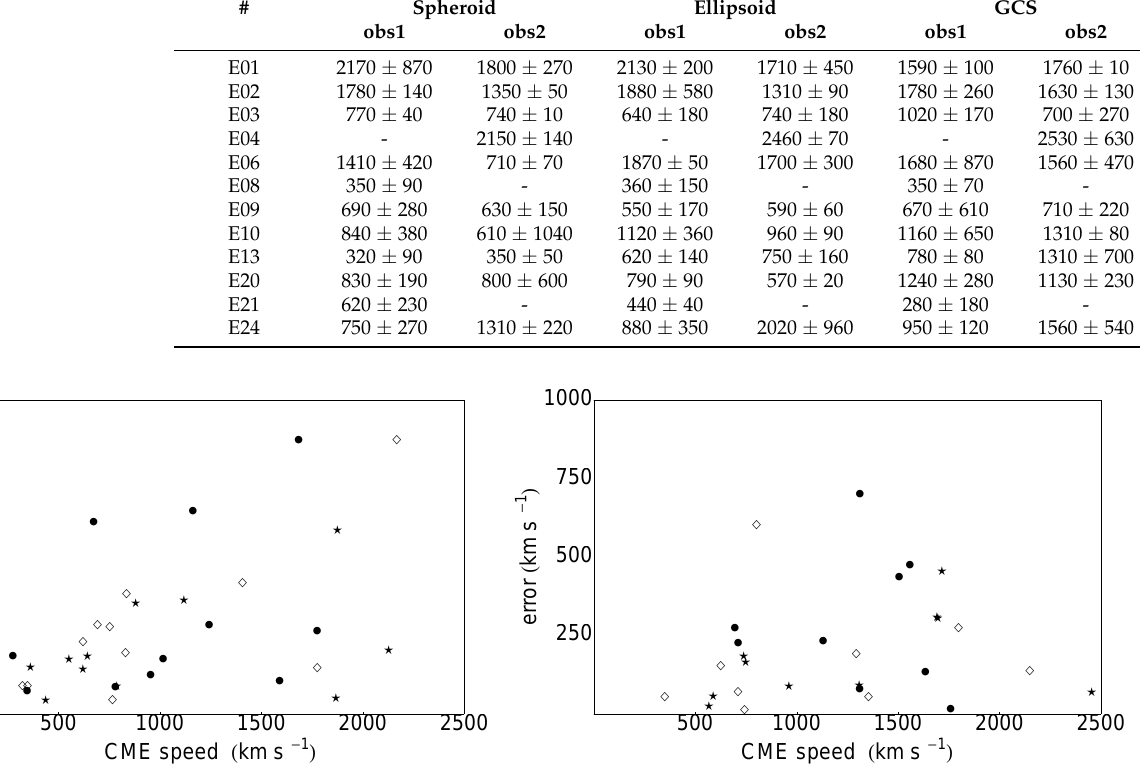
Figure 2. Scatter-plot between the 3D de-projection CME speeds obtained from the spheroid model (diamonds), the ellipsoid model (stars) and the GCS model (dots) and the error of the measurements for observers 1 ( left ) and 2 ( right